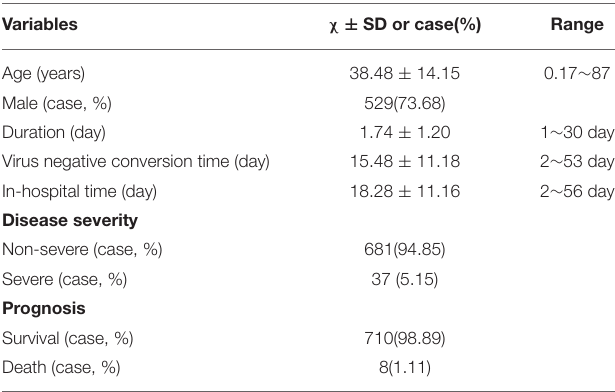
TABLE 1 | Baseline information ( n =